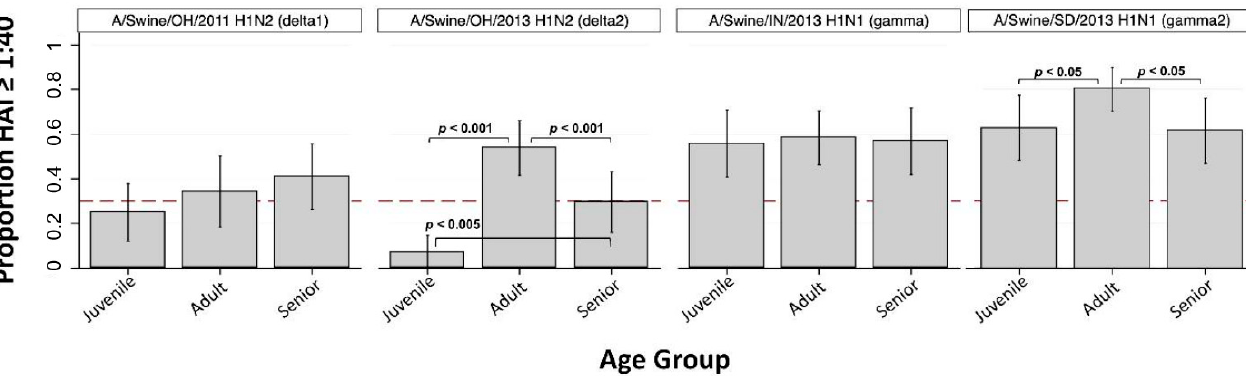
Figure 1. Seroprotection rate (SPR) against H1 subtype IAV-S by age group ( n = 3). Bar height indicates proportion of individuals with HAI antibody titer > 1:40 (seroprotection rate; SPR) within Juvenile (<18 years old), Adult (18 to 49 years old), and Senior ( ≥ 50 years old) age groups. Dashed red line at y = 0.3 corresponds to SPR of 30%. Vertical spikes and caps indicate 95% confidence interval of the proportion. Significant difference in proportions between groups are indicated when present by horizontal brackets and p-values (Pearson’s chi-squared). Table 2. Seroprotection rates a against study influenza A viruses by age group b and overall.